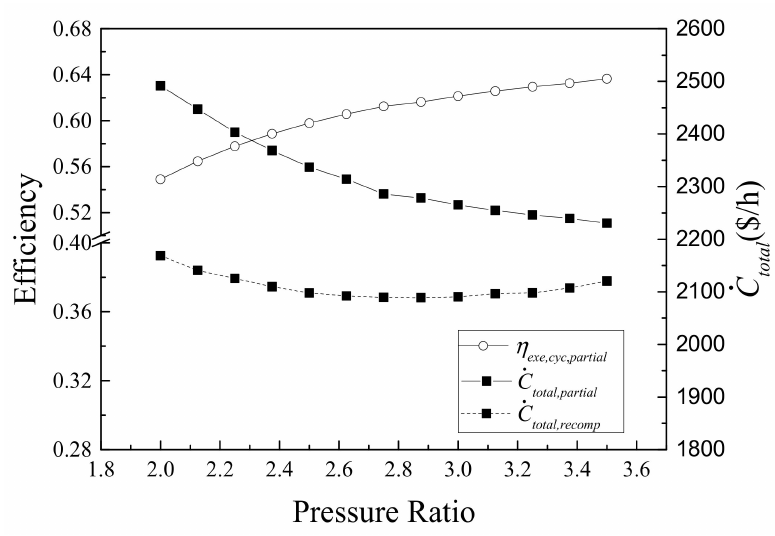
. C total with the partial-cooling cycle compared with the recompression cycle. Figure 10. Effects of β on . . C total comprises capital investment, operation, and maintenance costs ( Z ), and the cost . . C L + D ). The effect of β on C L + D is generally larger than from exergy loss and destruction ( . . . . Z , and the variation in Z , C L + D with β introduces changes in C total . Considering that on the increase in β indicates that the maximum cycle pressure would be high, further causing . . Z of compressors and turbines. Therefore, Z slightly increased with the rise in β , additional . . Z , the variation in C L + D is complicated due to exergy loss as shown in Figure 11. Unlike . C L + D significantly dropped initially and and destruction in the partial-cooling cycle, and then declined from 984.35 USD/h to 660.20